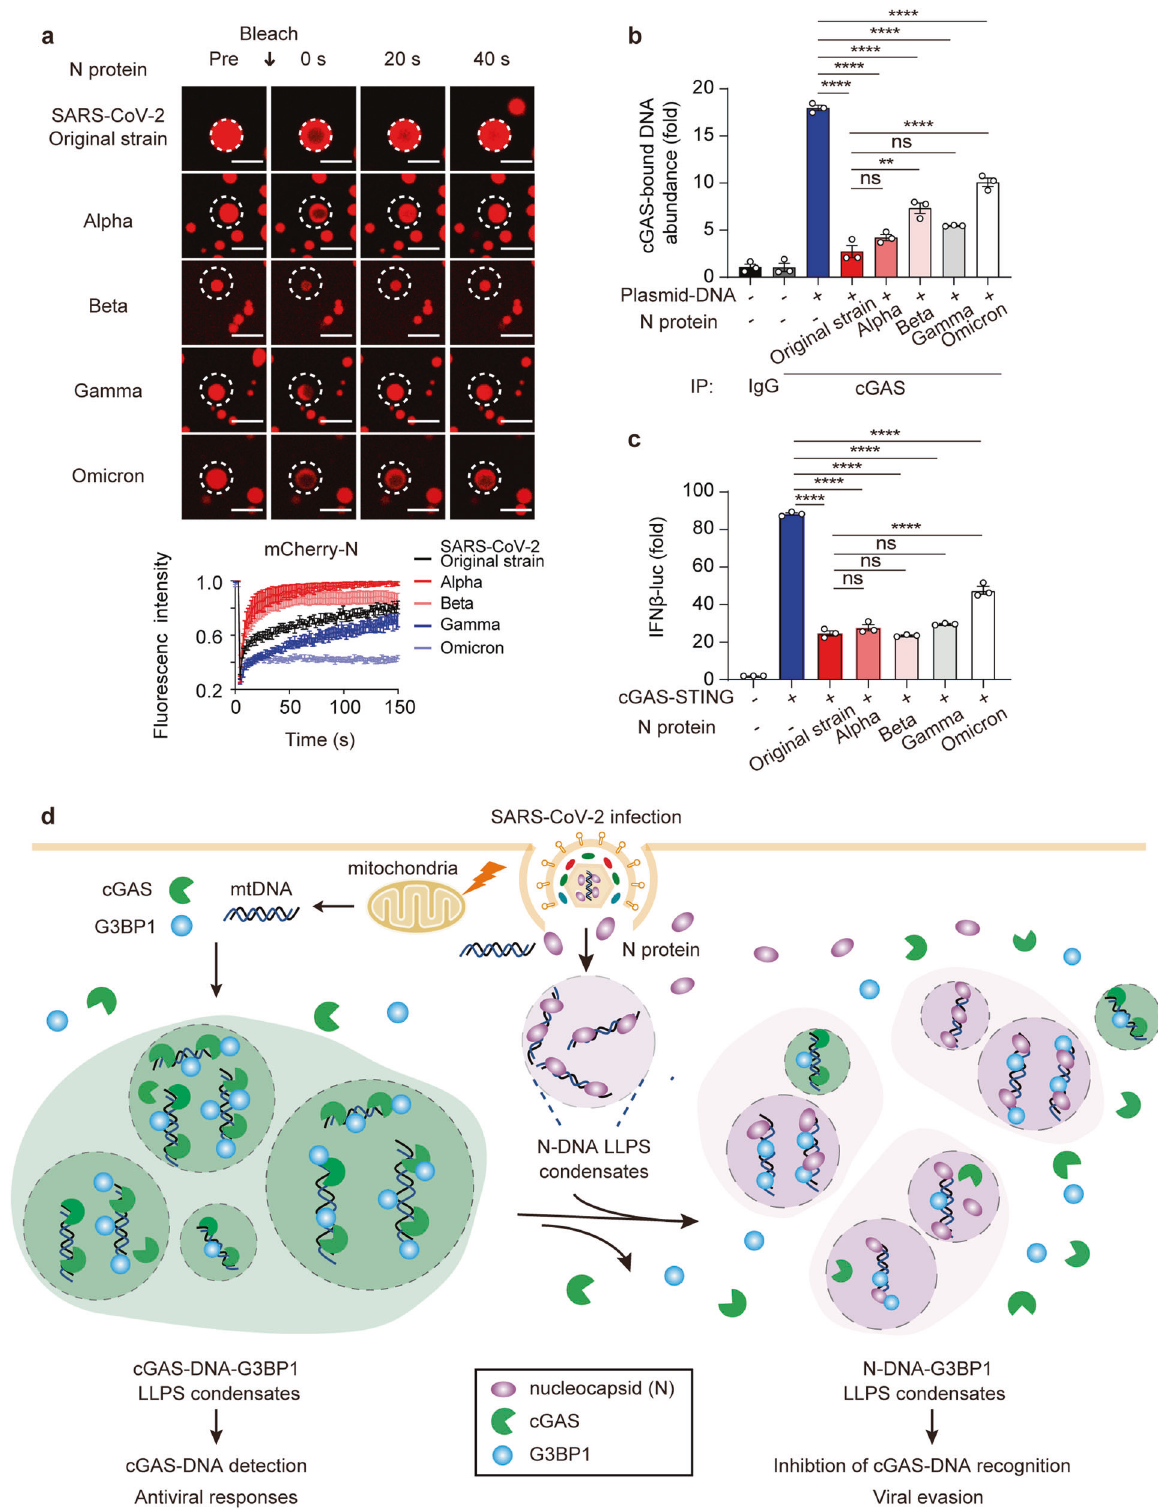
Viruses SARS-CoV-2 (Accession number: MT123290) virus generation and titer measurement were performed in Vero E6 cells, as previously described. 40,64 After stimulating with SARS-CoV-2 virus, the cells were gently shaken every 15 min within 2 h, then changed to fresh